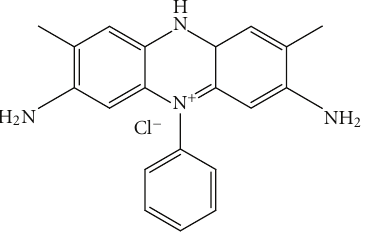
Figure 1: The molecular structure of safranine compounds.